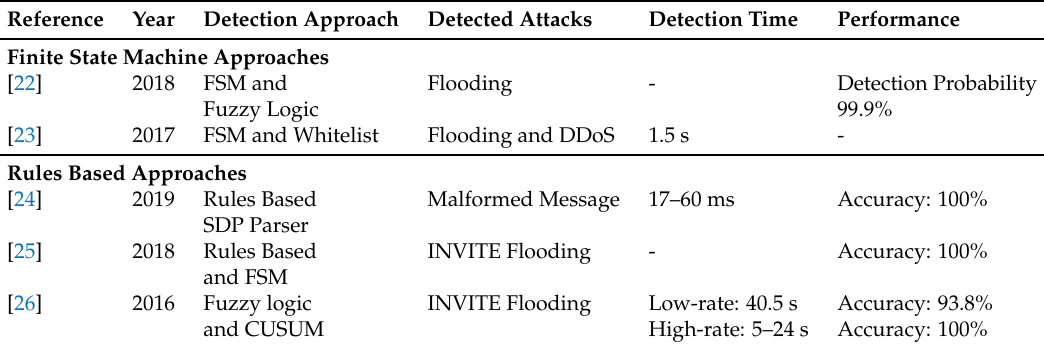
Table 2. Analysis of the characteristics of surveyed